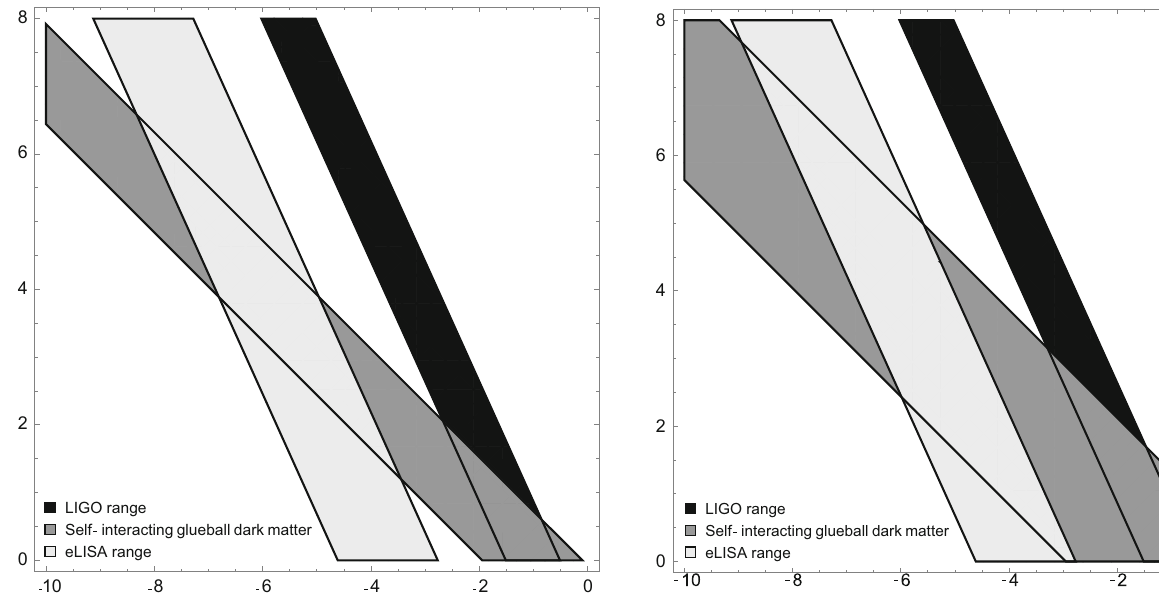
Fig. 7 The m – N parameterspace,fortheself-interactingglueballdark matter, in the current brane tension bound σ (cid:2) 3 . 2 × 10 − 6 GeV 4 [20], for the EMGD procedure, for k = 2. The black (light gray) band showsthegravitationalwavepeakfrequencytobedetectedbytheLIGO (eLISA) experiment, whereas the gray band shows the gravitational wave peak frequency emitted from SU( N ) EMGD dark star